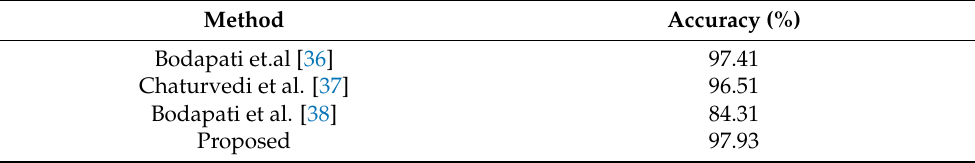
Table 4. Comparison with state-of-the-art approaches over the Aptos-2019 dataset.